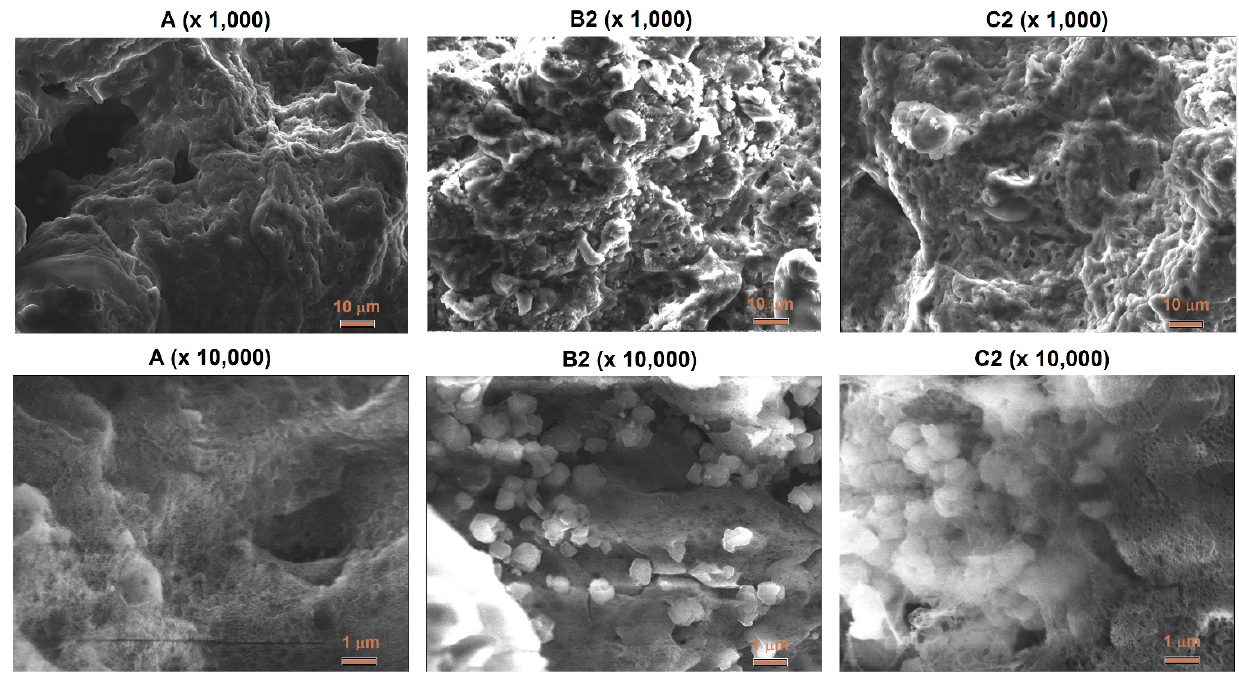
Figure 5. SEM images of ANFO-based samples.